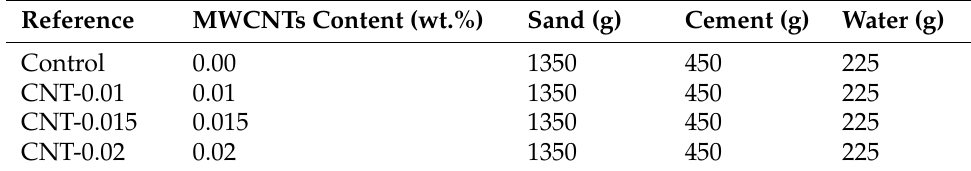
Table 3. Mortar mix